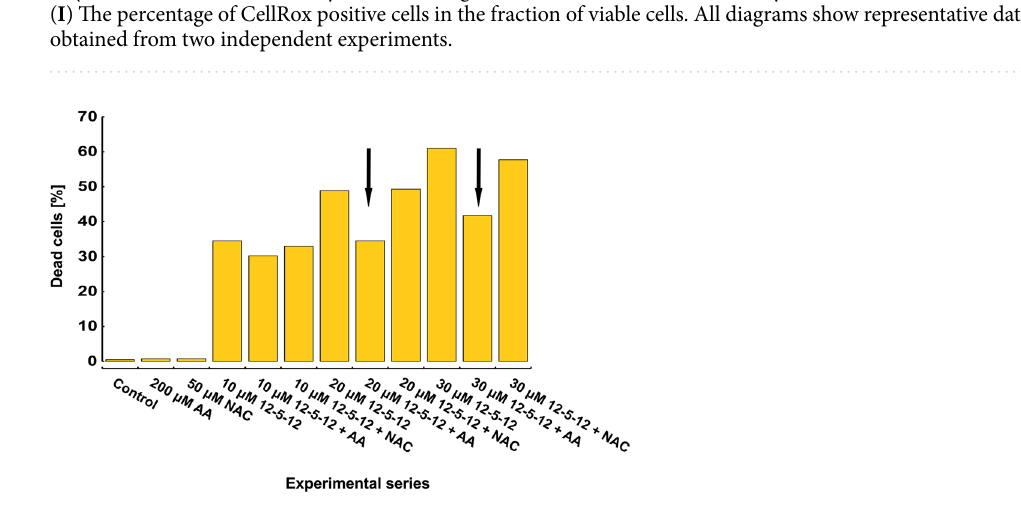
Figure 9. Reactive oxygen species (ROS) detection during subsequent hours of incubation with the 12-5-12 surfactant at the concentration of 20 μmol/L. ( A – E ) The diagrams show the percentage of ROS positive (+) and ROS negative (−) cells in the fractions of viable and non-viable cells after different times of exposure to the tested compound. ( F , G ) The diagrams show the percentage of ROS positive (+) and ROS negative (−) cells in the fractions of viable and non-viable cells after the exposure to the tested compound and treatment with 50 μmol/L NAC 1 h before analyses. ( H ) Changes in CellRox fluorescence intensity in the fraction of viable cells.